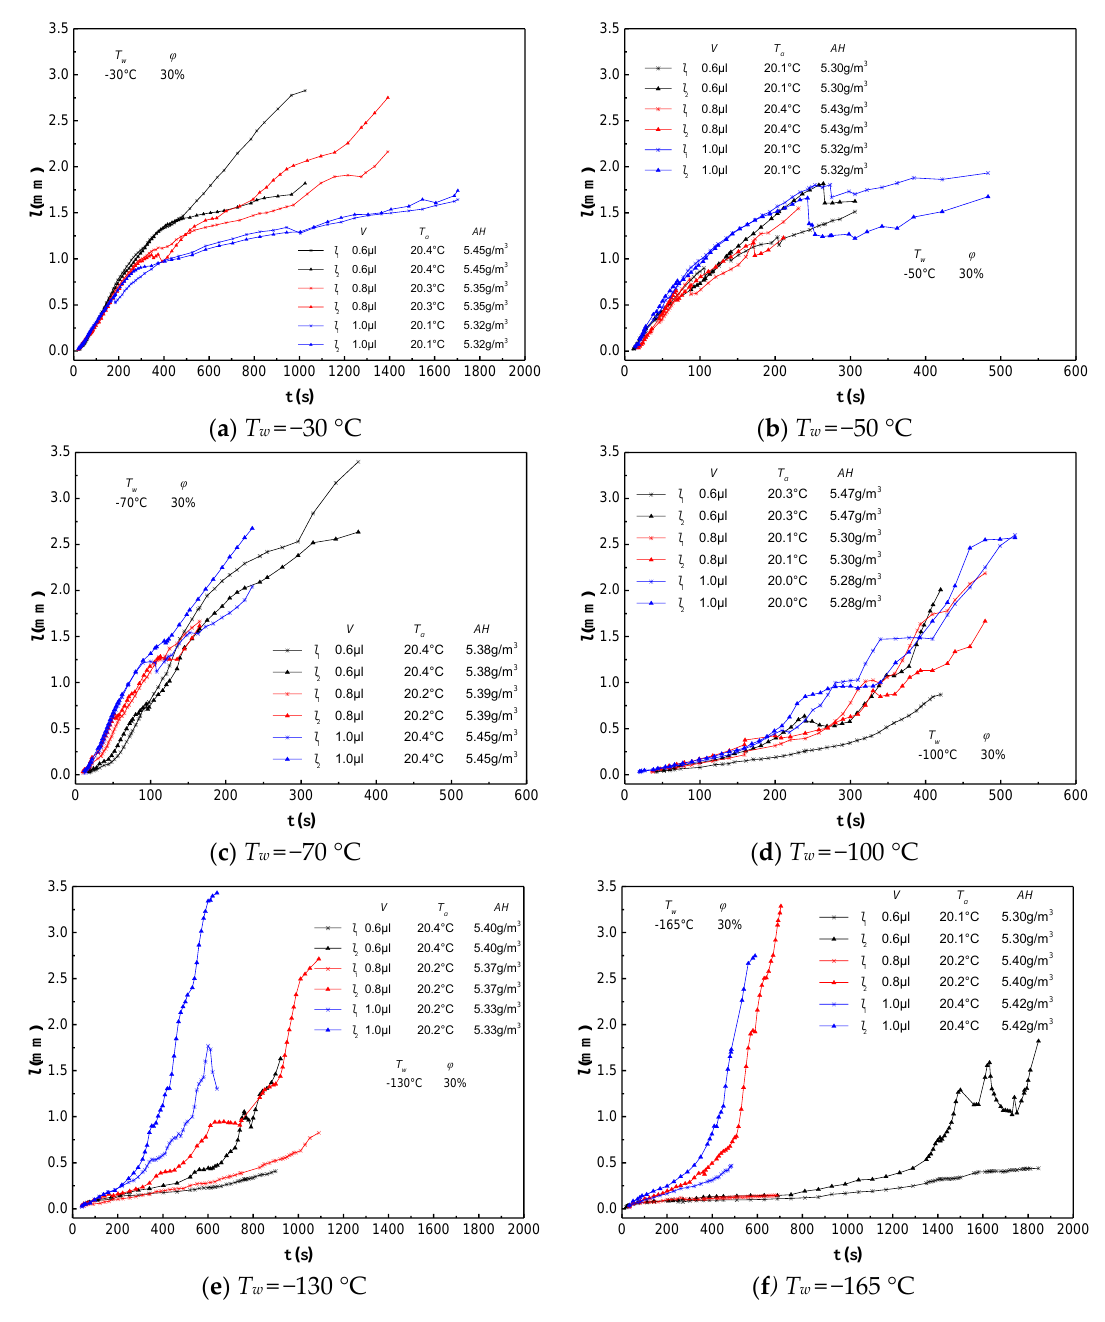
Figure 6. Influences of cold surface temperature on frost crystal dendrite growth along vertical direction.